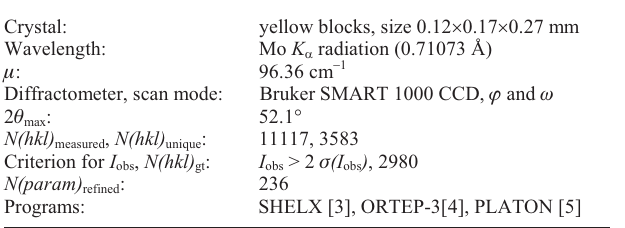
Table 1. Data collection and handling.